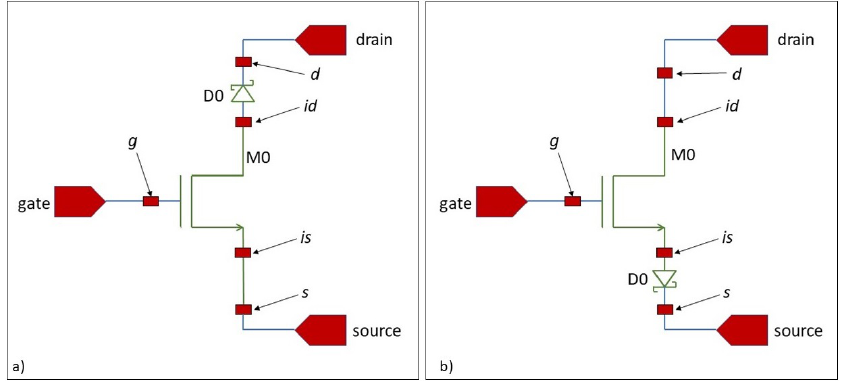
Figure 6. Circuit model for p-type ( a ) and n-type ( b ) OTFT,